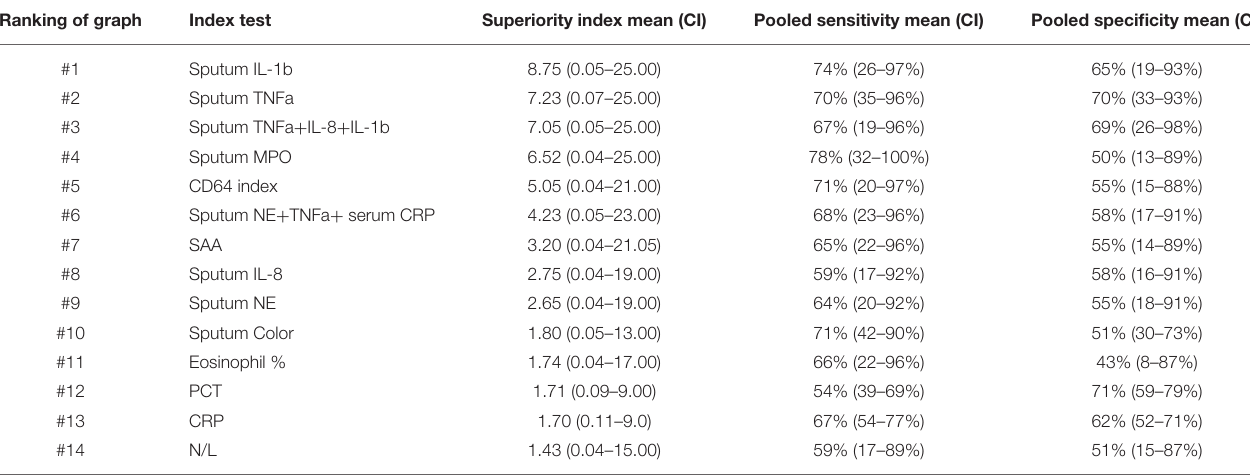
TABLE 2 | Index tests ranked by their superiority indices. Pooled sensitivity and specificity of index tests are also shown. Ranking of